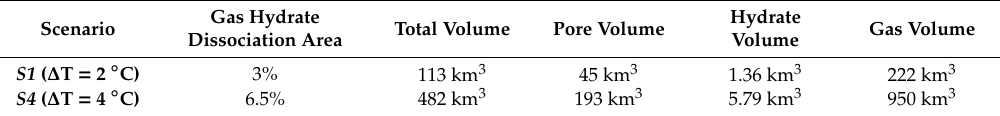
Table 1. Amount of gas released by thermal dissociation of gas hydrate, considering a porosity of 40% and a mean hydrate saturation of 3% according to the minimum value proposed by [21,30].